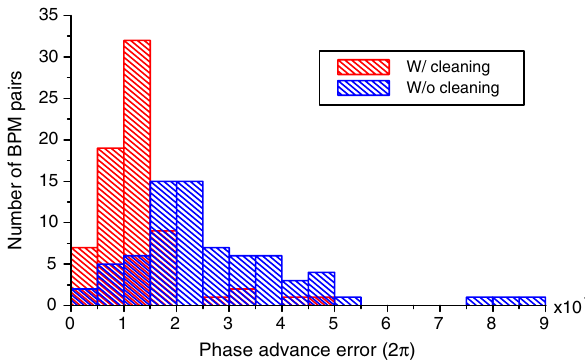
FIG. 6. Statistical error of phase advance measurement with and without SVD data cleaning. The standard deviation is computed over four measurements. The plot shows the error in the vertical plane.